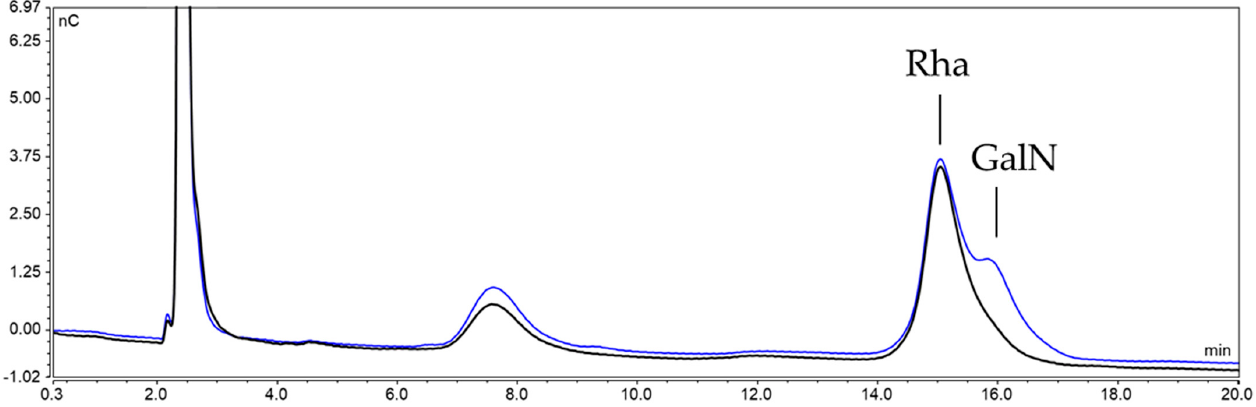
Figure A7. Overlay HPAEC-PAD chromatograms of S. flexneri 6 OAg hydrolyzed with TFA 2 M at 100 °C for 2 h (black line) or 6 h (blue line).